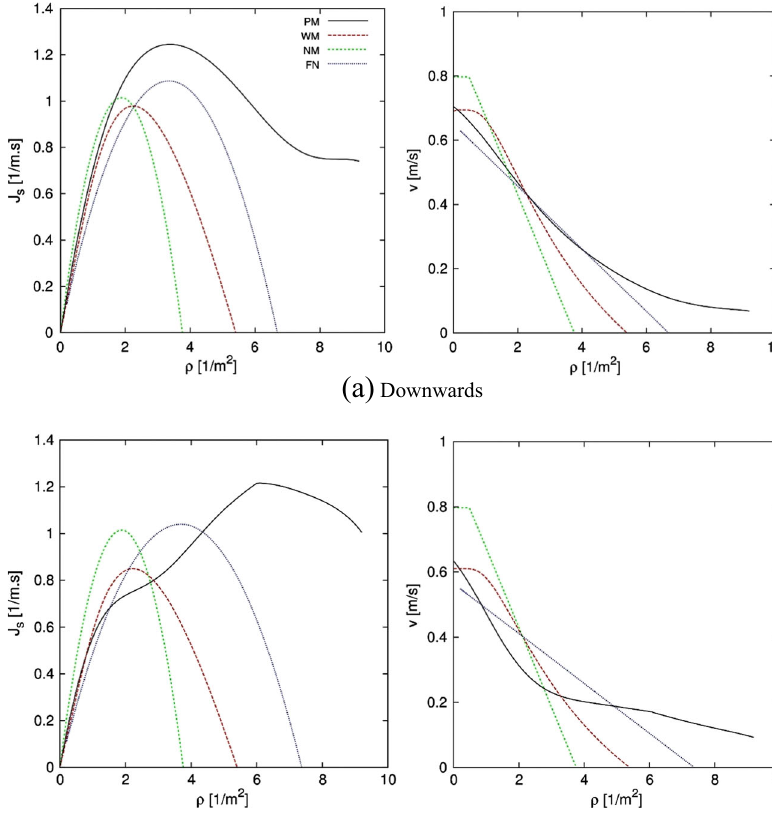
Fig. 5 Fundamental diagrams of stairs given by different planning guidelines [PM: Predtechenskii and Milinskii (1978) [32], NM: